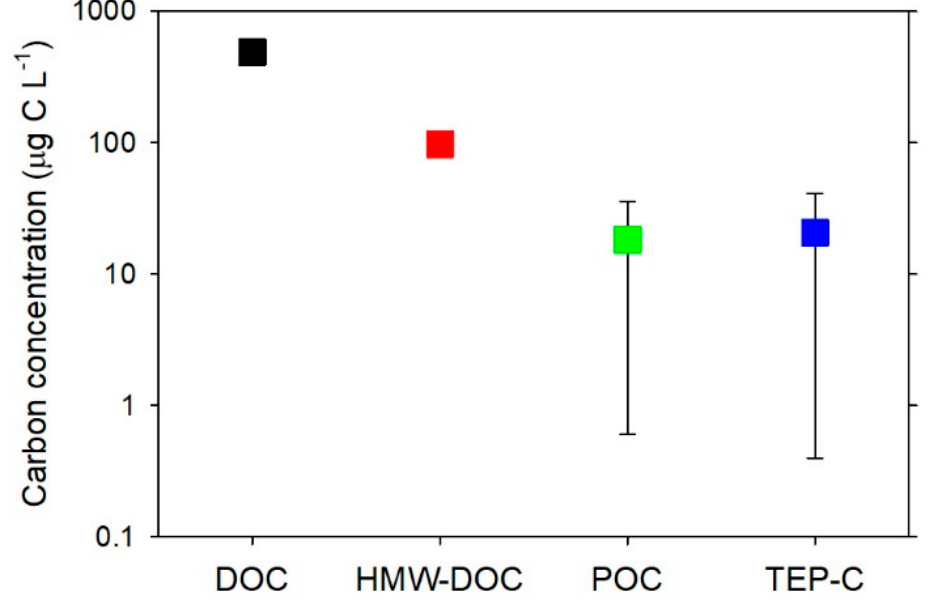
Figure 2. Concentration ranges of DOC, high-molecular-weight DOC (HMW-DOC), POC, and TEP-C in the bathypelagic layer. Error bars represent the minimum and maximum values reported in the literature and the symbols indicate the midrange values. DOC and POC values are from Nagata et al. [13]. TEP-C is from Yamada et al. [19] and Engel et al. [25]. The large ranges for POC and TEP-